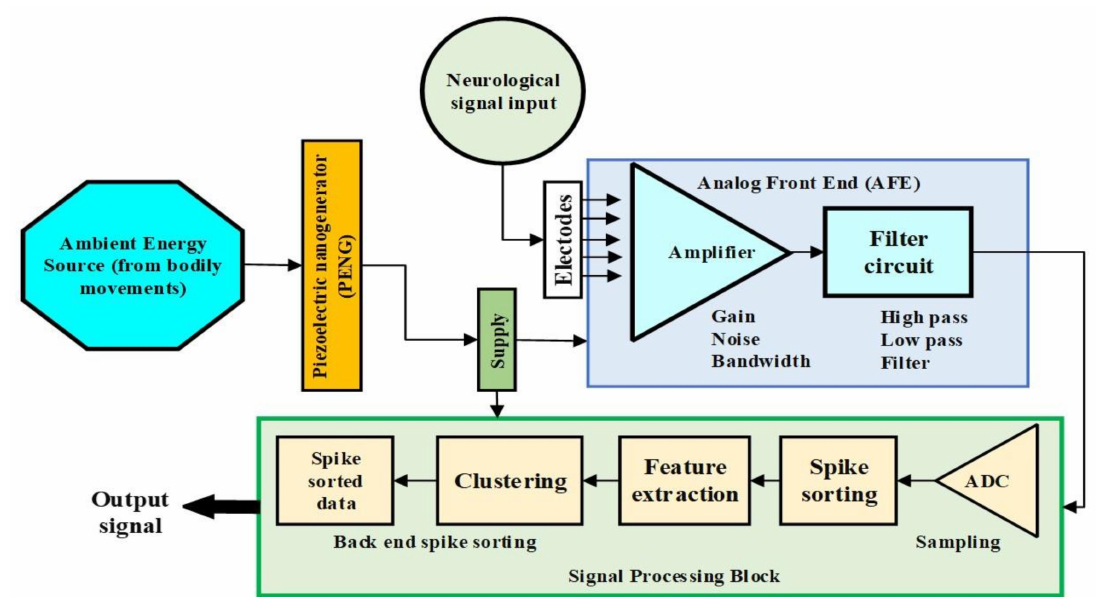
Figure 13. Schematic diagram of PENG supply for the analog front end (AFE) and signal processing block in a